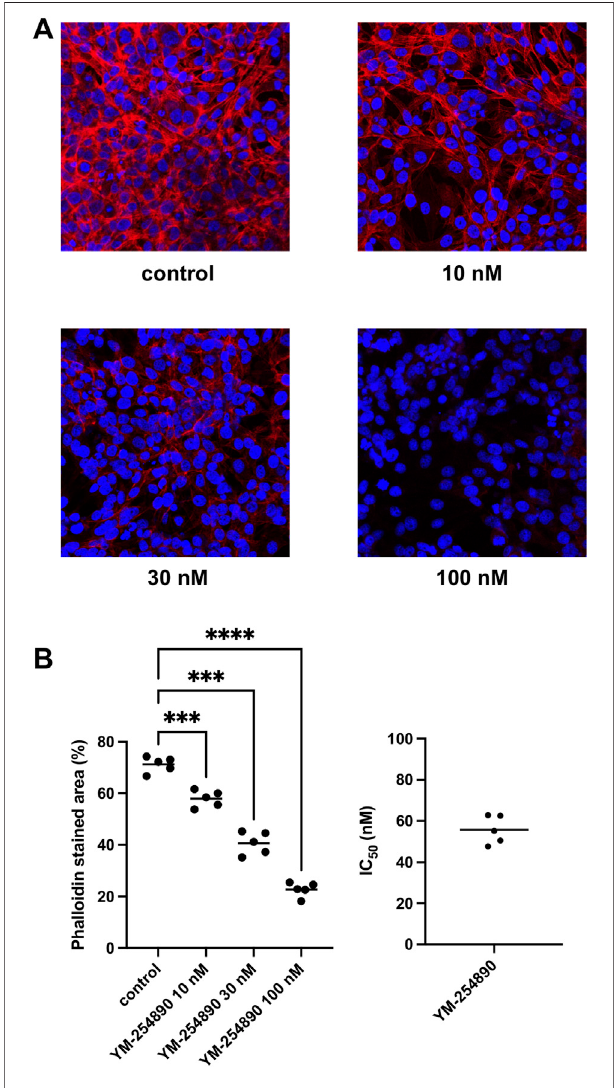
FIGURE11| InhibitionofWPMY-1cellactinorganizationbyYM-254890 using concentrations of 10, 30, and 100 nM. Shown are actin fi laments, visualized by phalloidin staining, after 72 h of exposure from series using cell cultures from n = 5 independent experiments for each panel. The cells were either allocated to a control (DMSO, 10 μ l/ml) or YM-254890 group and incubated for 72 h. Actin fi laments were visualized by phalloidin staining and fl uorescencemicroscopy,whilethenucleiwerevisualizedusingDAPIstaining. IC50 values were calculated by curve fi tting ofeach single experiment. Shown are representative single experiments from series of n = 5 independent experimentsforeachpanel (A) ,andquanti fi cationofallexperimentsasmeans in scatter plots containing data of each individual experiment quanti fi ed as percentage (%) of phalloidin-stained area (*** p < 0.001, **** p < 0.0001) after 72 h (B) with corresponding IC50 values from all fi ve experiments (right).